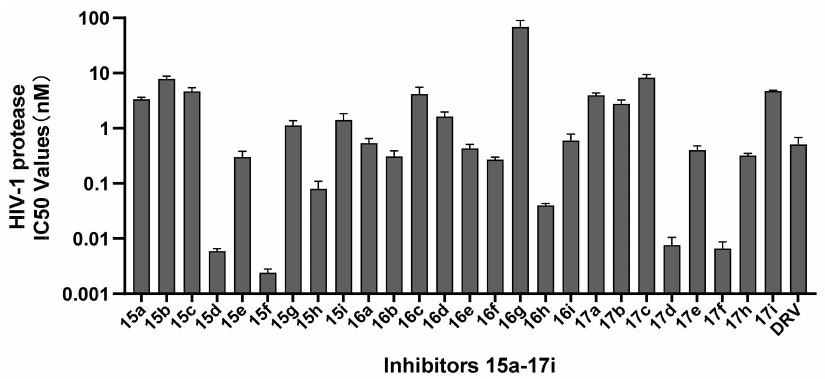
Figure 3. Enzymatic inhibitory activity of inhibitors. All assays were conducted in triplicate, and the data shown represent mean values ( ± SD) derived from the results of three independent